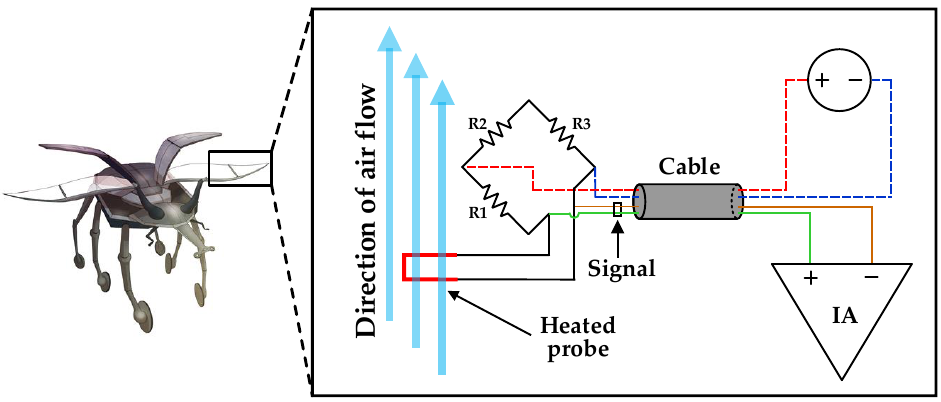
Figure 1. Hot wire anemometer structure for modeling insect’s wing and measuring airflow.